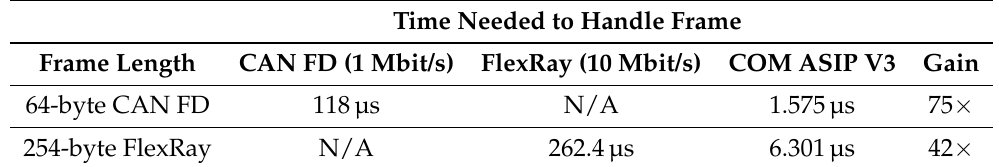
Table 7. Throughput comparison between COM ASIP V3 and different communication buses. Time Needed to Handle